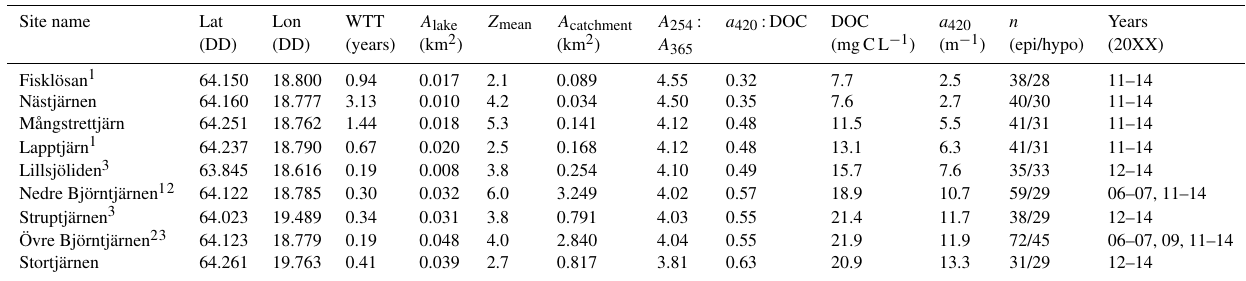
Table 1. Characteristics and sampling details for the nine study lakes. Variables from left to right: decimal degree (DD) WGS84 latitude (Lat) and longitude (Lon) coordinates, water transit time (WTT), area of lake ( A lake ) , mean depth of lake ( Z mean ) , area of catchment ( A catchment ) , ratio between the absorbance at the wavelengths of 254 and 365nm ( A 254 : A 365 ) , carbon specific absorbance at 420nm ( a 420 :DOC), dissolved organic carbon (DOC), absorbance at 420nm ( a 420 ) , number of epilimnetic and hypolimnetic samples ( n ), and study years. The WTT and chemical characteristics are shown as mean epilimnetic values across all sampling